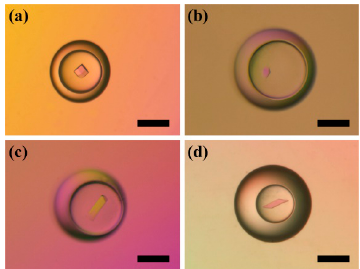
Table 1. The applied concentration of PEG 8000 in the continuous phase with different protein solutions. Protein Concentration (mg/mL) Applied Concentration of PEG 8000 (% w / w ) Lysozyme 100/80/50 40 Thaumatin 20/10 40 Trypsin 80/60/40 30 Horseradish peroxidase 10/5